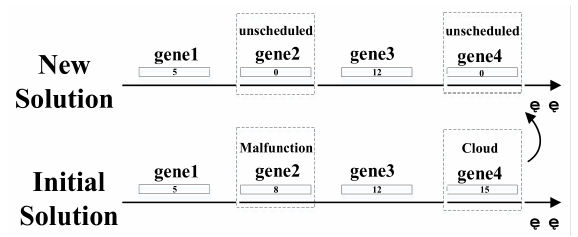
Figure 4. State update of scheduling